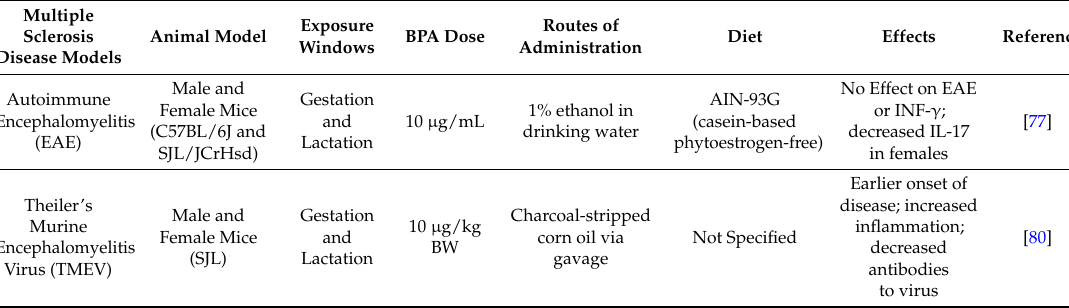
Table 1. Summary of animal multiple sclerosis studies on BPA exposed